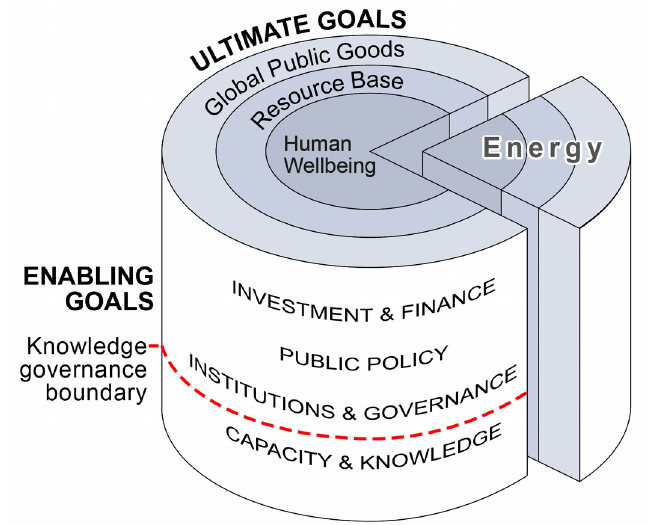
Figure 1. Sustainable development framework: three tiers of ultimate goals and four layers of enabling goals. Knowledge governance sits at the dashed line between the two base layers. Adapted from Nilsson et al.